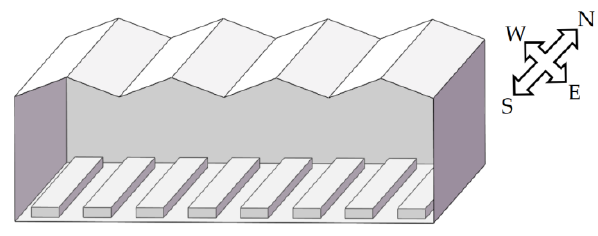
Table 2. Venlo greenhouse parameters.